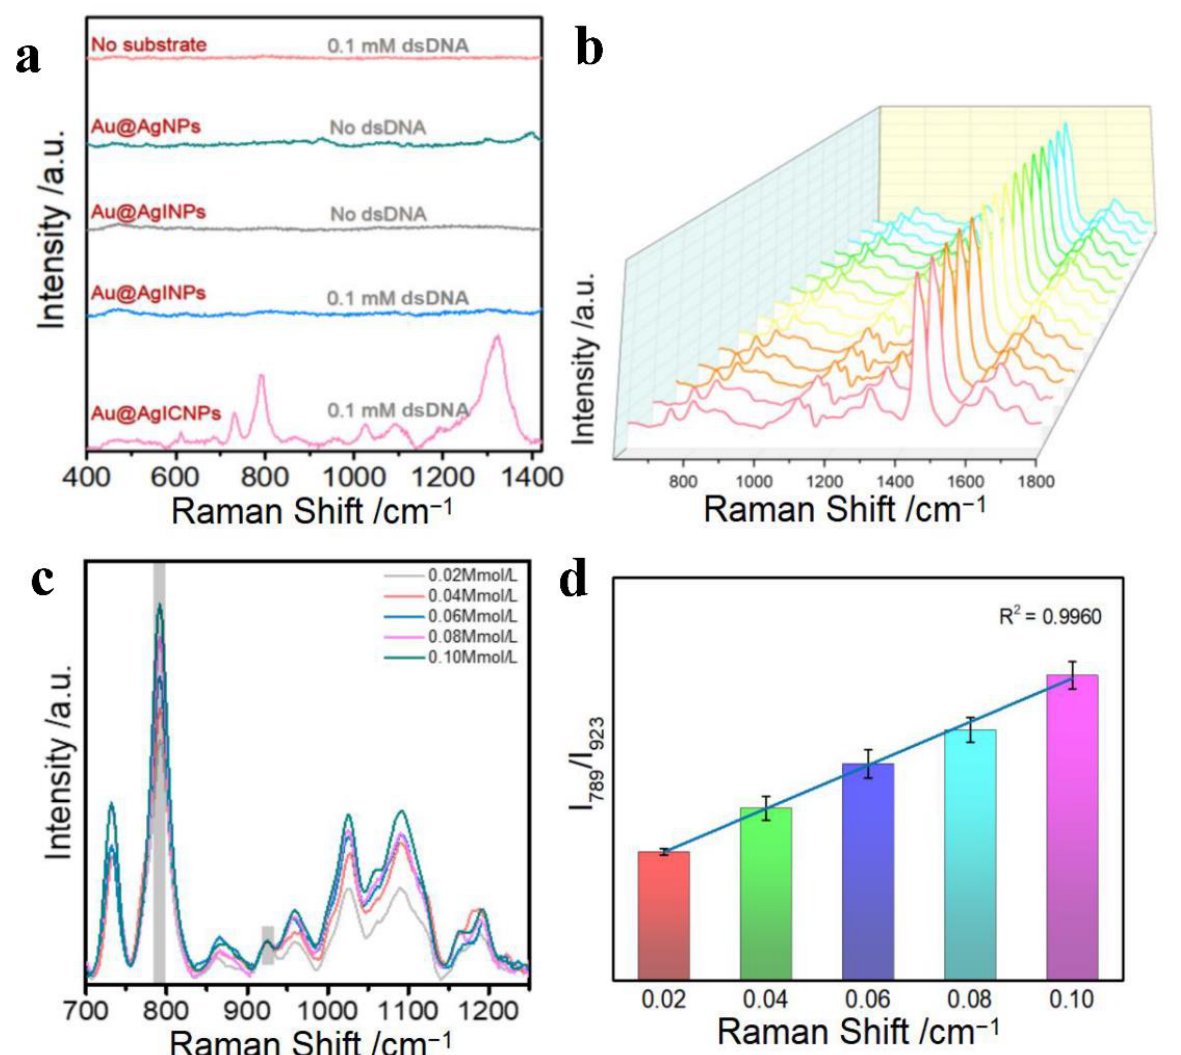
Figure 2. ( a ) SERS spectra of double-stranded DNA D3 under different conditions; 0.10 mM SERS spectra of D3 (red line); SERS spectra of Au@AgNPs without D3 (green line); SERS spectra of Au@AgINPs without D3 (grey line); SERS spectra of 0.10 mM D3 in Au@AgINPs (blue line); SERS spectra of 0.10 mM D3 in Au@AgICNPs (pink line). ( b ) Random SERS spectra of 15 sets of D3. ( c ) SERS spectra of different concentrations of D3 (0.02–0.10 mM). ( d ) Histograms of I789/I923 values corresponding to changes in D3 concentrations.